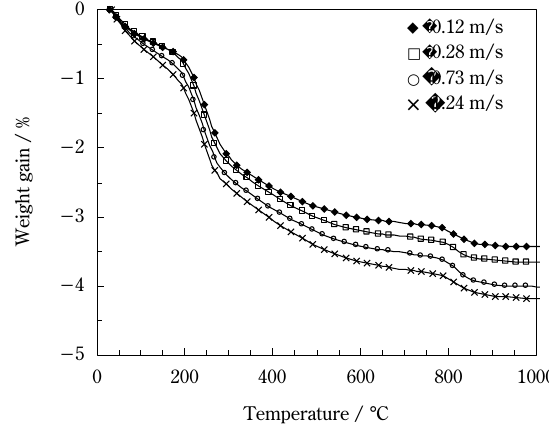
Fig. 7 XRD patterns of BaTiO 3 particles prepared by different mixing condition: (1) 0.12 m/s (2) 0.28 m/s (3) 0.72 m/s (4) 1.24 m/s.